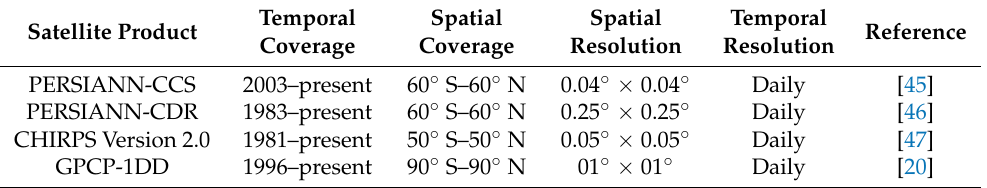
Temporal Spatial Spatial Temporal Reference Coverage Coverage Resolution Resolution